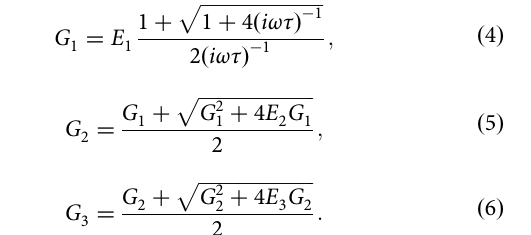
Fig. 3 A self-similar hierarchical rheological model of the cells. a The 1st-level hierarchy consists of a ladder-like structure with springs along the struts and dashpots on the rungs of the ladder. b The 2nd-level self-similar hierarchy is constructed with the fi rst-level hierarchy represented as a building block J 1 . c The 3rd-level self-similar hierarchy is constructed with the second-level hierarchy represented as a building block 1st-level hierarchy as a building block, as shown in Fig. 3b.